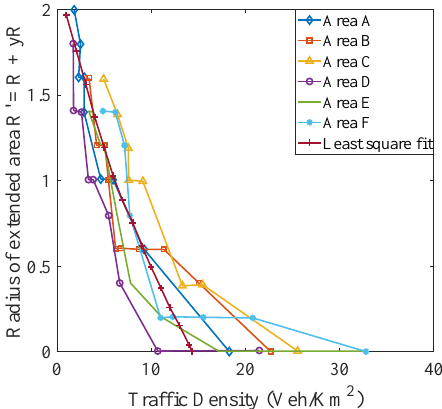
Figure 13. Percentage increase of the critical radius relative to the radius of the hovering area vs. traffic density graphs in different hovering areas, together with their least squares fit used in the adaptive version of Reference